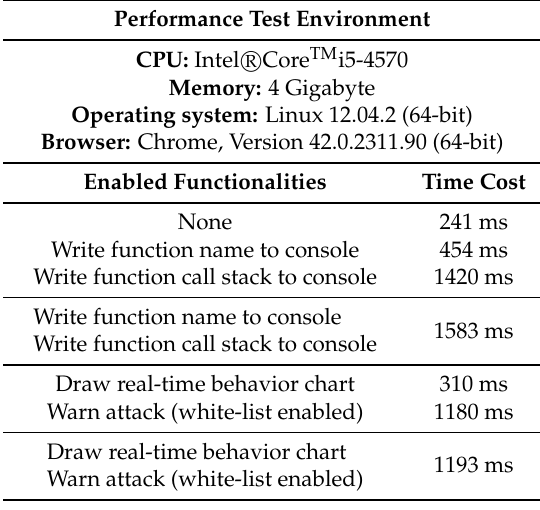
Table 3. Time cost of different